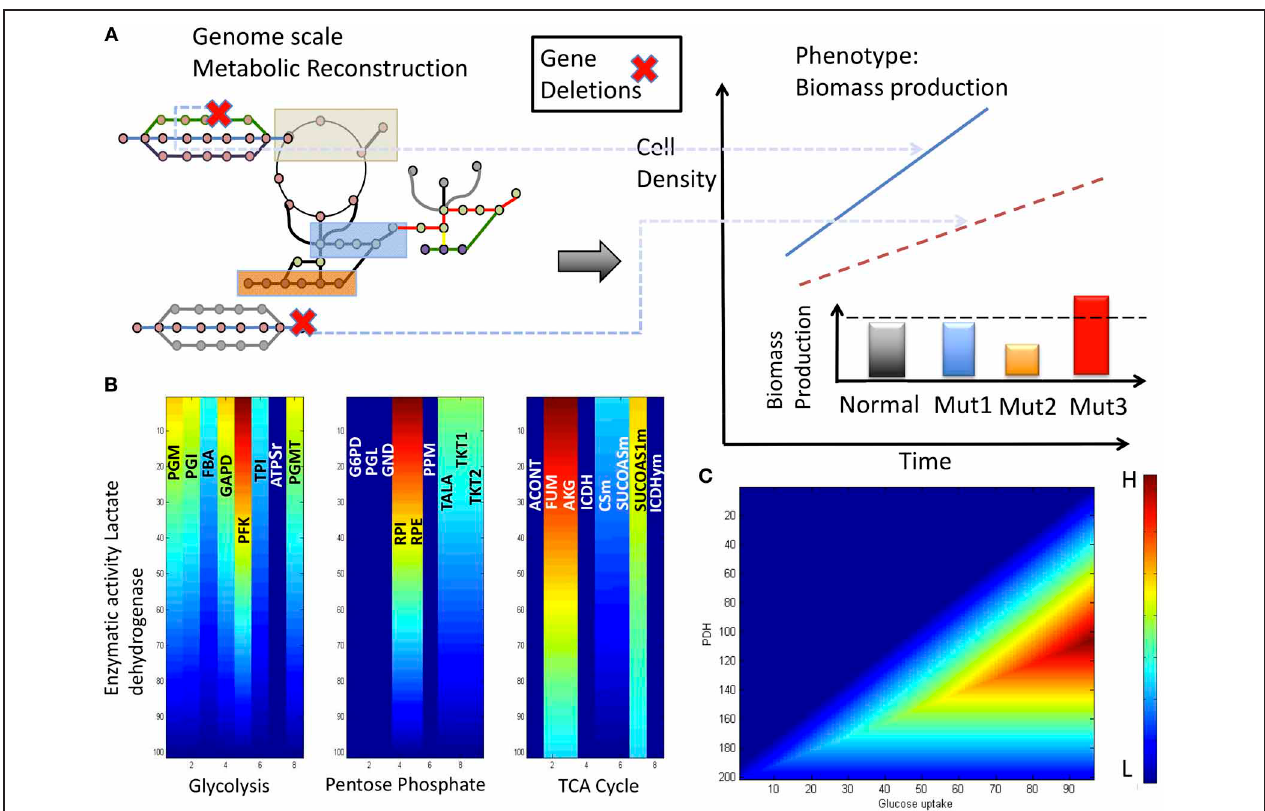
(Resendis-Antonio et al., 2010). Supporting this finding, panel (B) shows the effects that variations on the enzymatic activity of LDH have on some enzymes participating in glycolysis, TCA cycle and pentose phosphate. As the figure shows according the metabolic activity of LDH decrease, we note a reduced activity on all the enzymes integrating these pathways. Regions in red and blue represent a higher (H) and lower (L) metabolic flux activity, respectively. (C) Phenotype phase plane considering the activity of pyruvate dehydrogenase ( PDH ) and glucose uptake